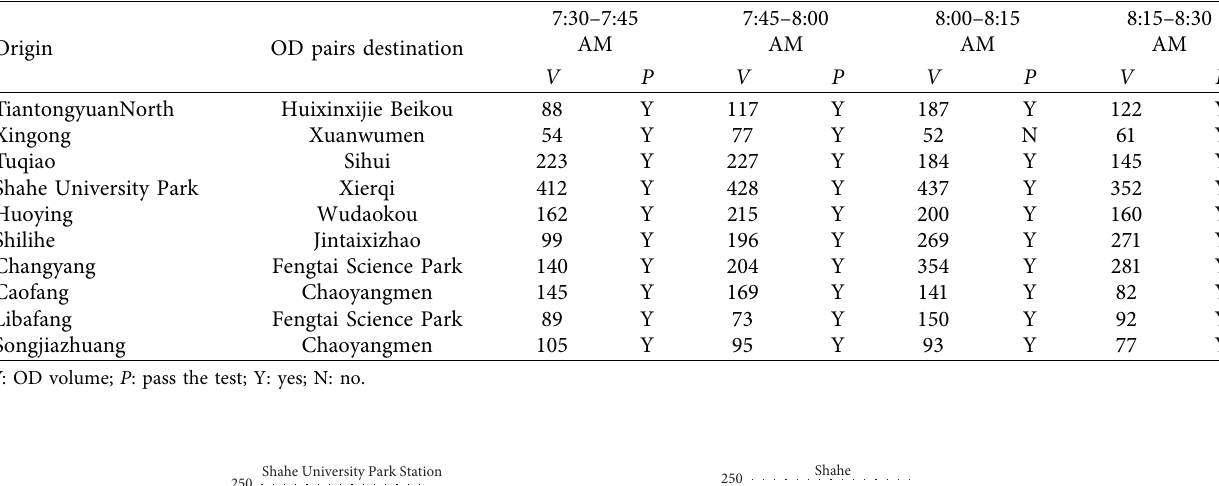
Table 4: T -test and F -test for OD travel time.